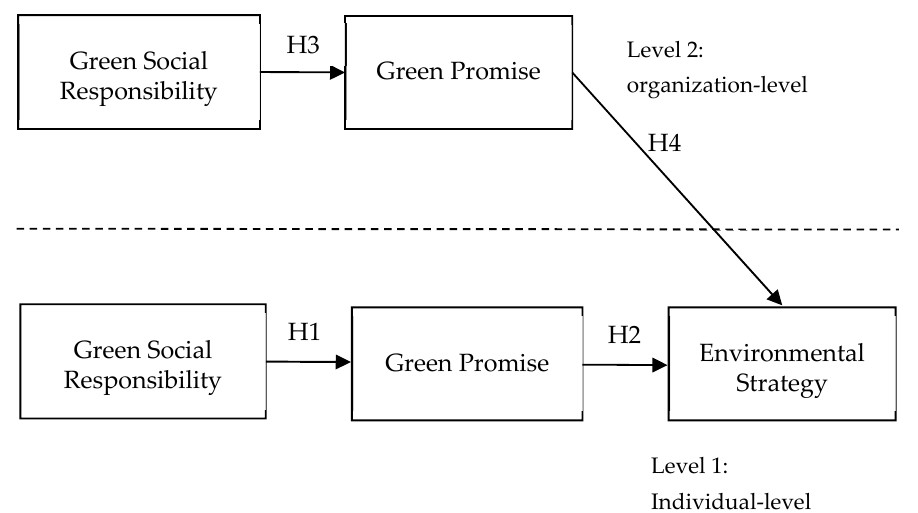
Figure 1. Research model of this research.